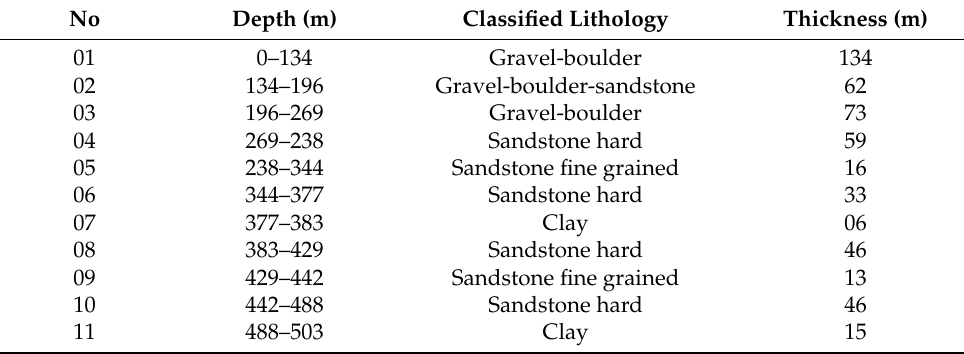
Table 8. Derived borehole lithology-based Normal resistivity logs (NRLs) (short/long) and sponta- neous potential logs